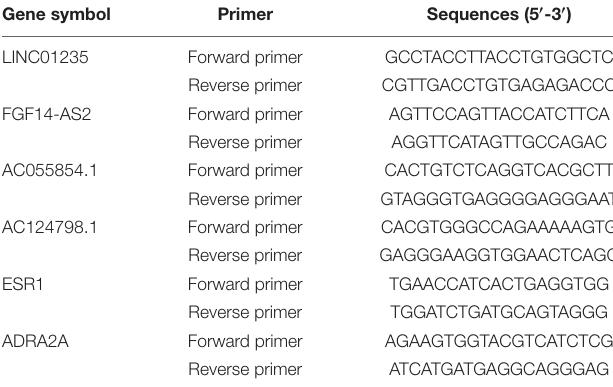
TABLE 2 | The sequences of